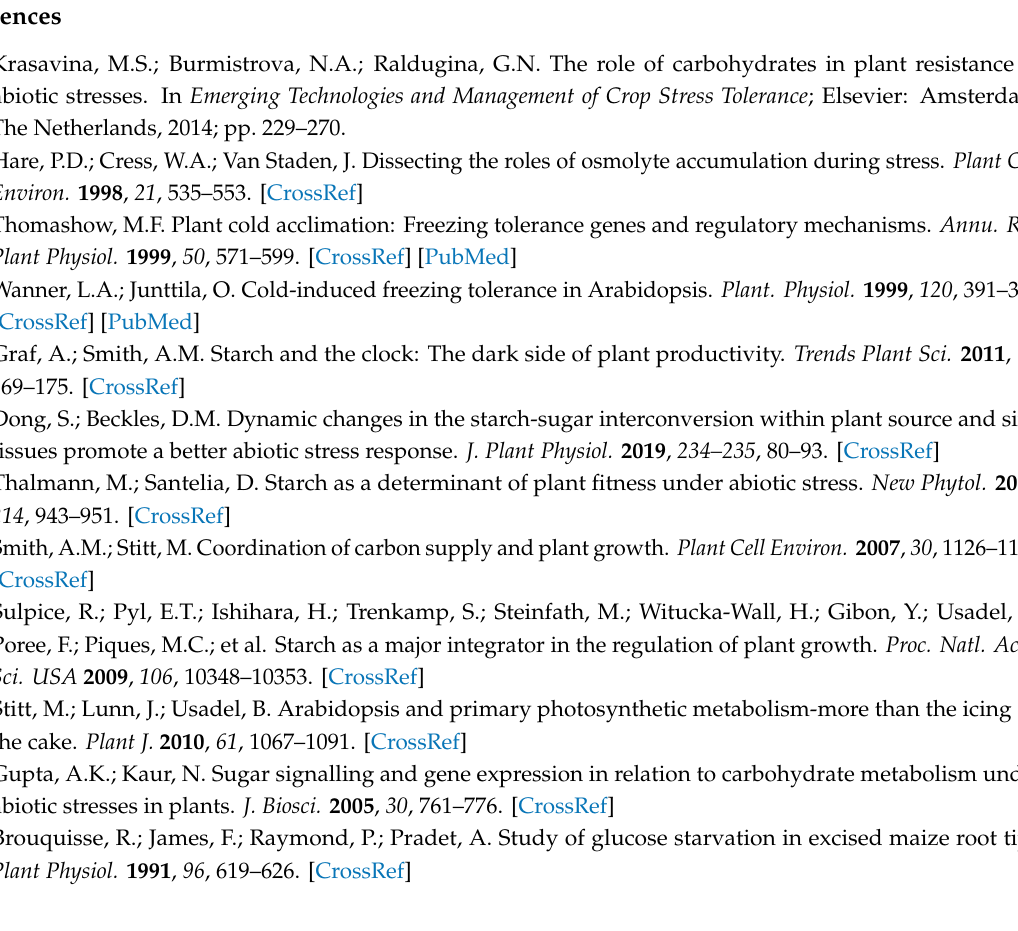
online in the Supplementary Materials. Table S1: Primer sequences for T-DNA verification. Table S2: Primer sequences and PCR product used for STY46 cloning. Table S3: Primers used for quantitative RT-PCR. Figure S1: Public expression data of STY46 created from Genevestigator ® . Figure S2: Public expression data of STY46 and related genes created from Genevestigator ®